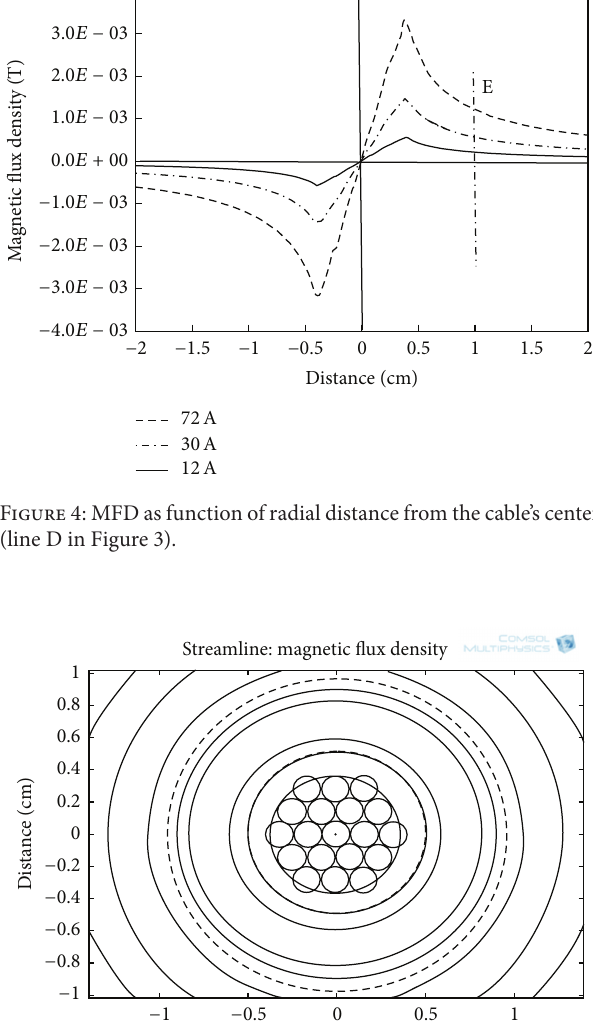
Figure 3: MFD distribution along a cross-section of a single-core insulated cable at a current amplitude of 72 A.